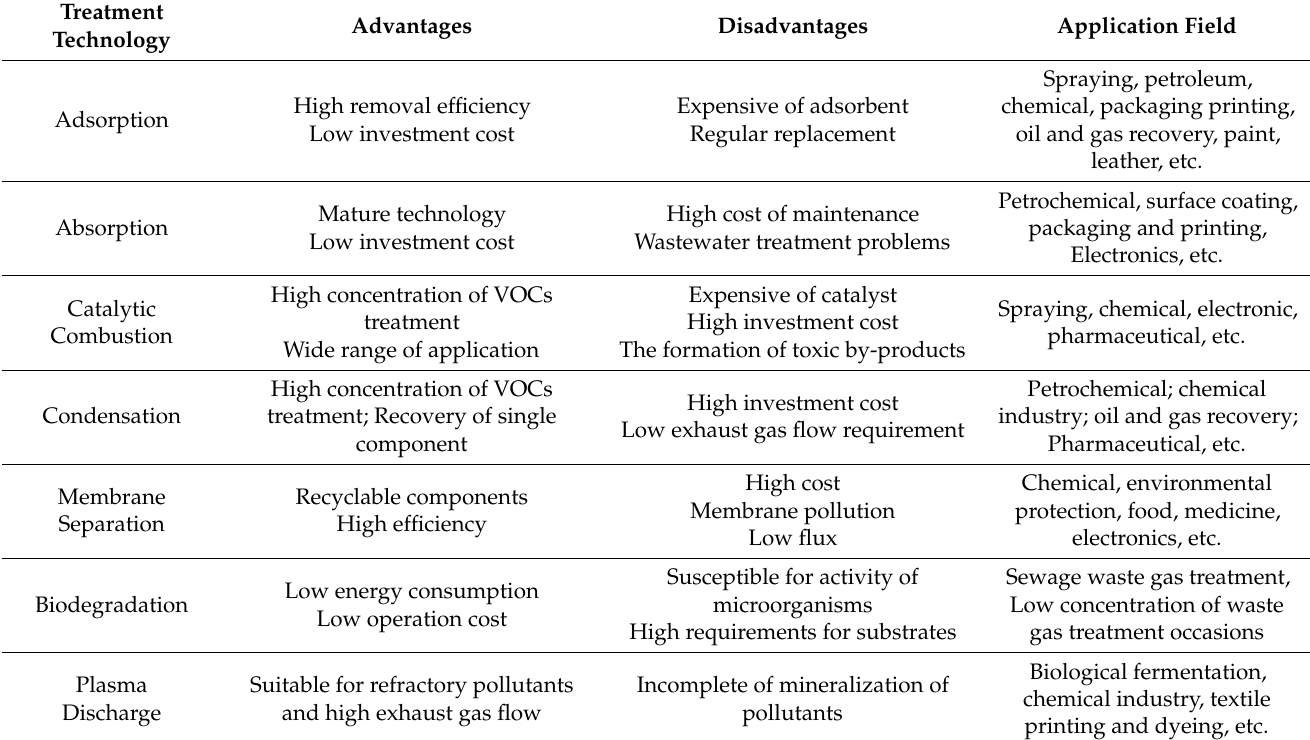
Table 1. Comparison of main technologies for VOCs